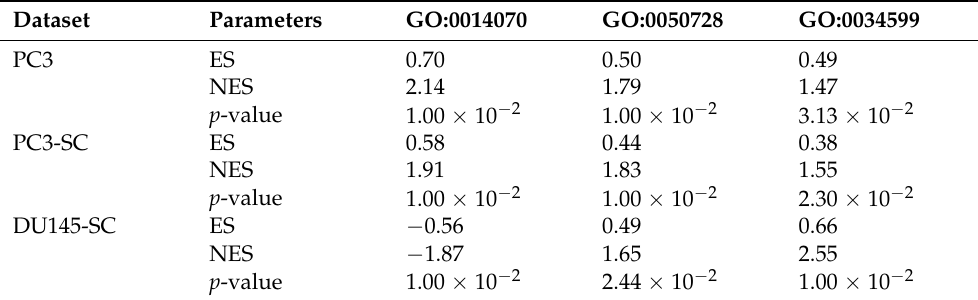
Table 2. Statistically significant pathways associated with the docetaxel resistance of PC3 and DU-145 cells, according to the Gene Ontology Biological Process 2021